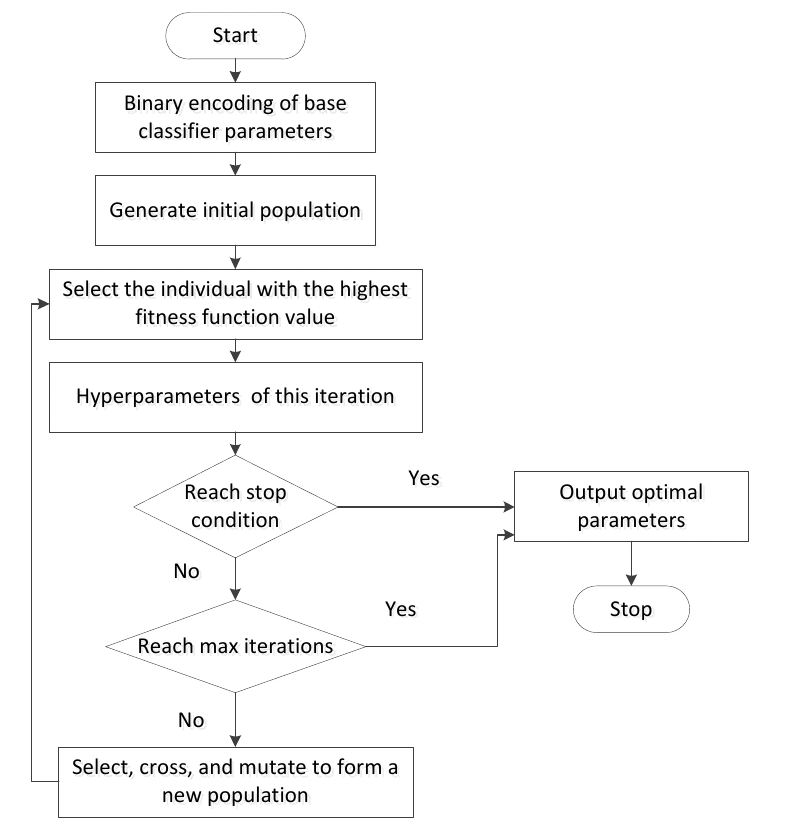
Figure 4. Flow chart of GA optimization.